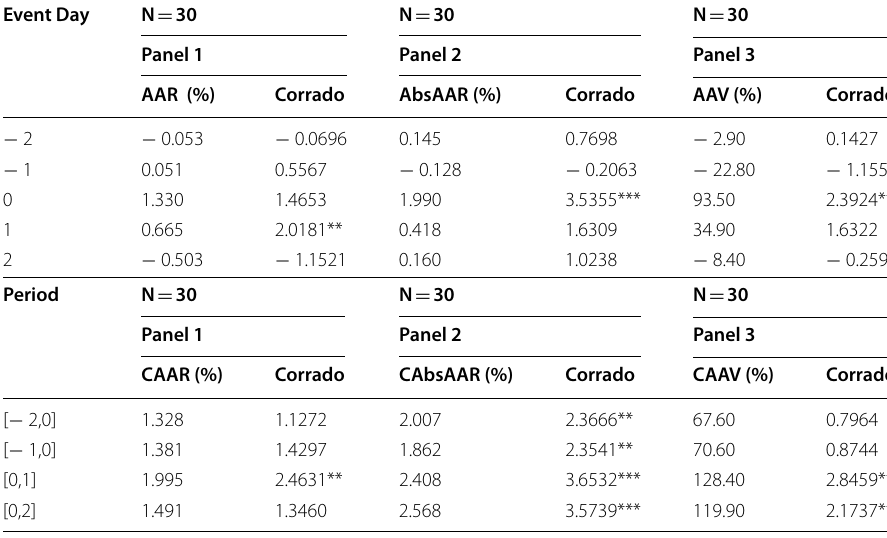
the date of the announcement of Pfizer’s COVID‑19 vaccine for the companies listed on the DJIA index. Results obtained using Kenneth R. French factor